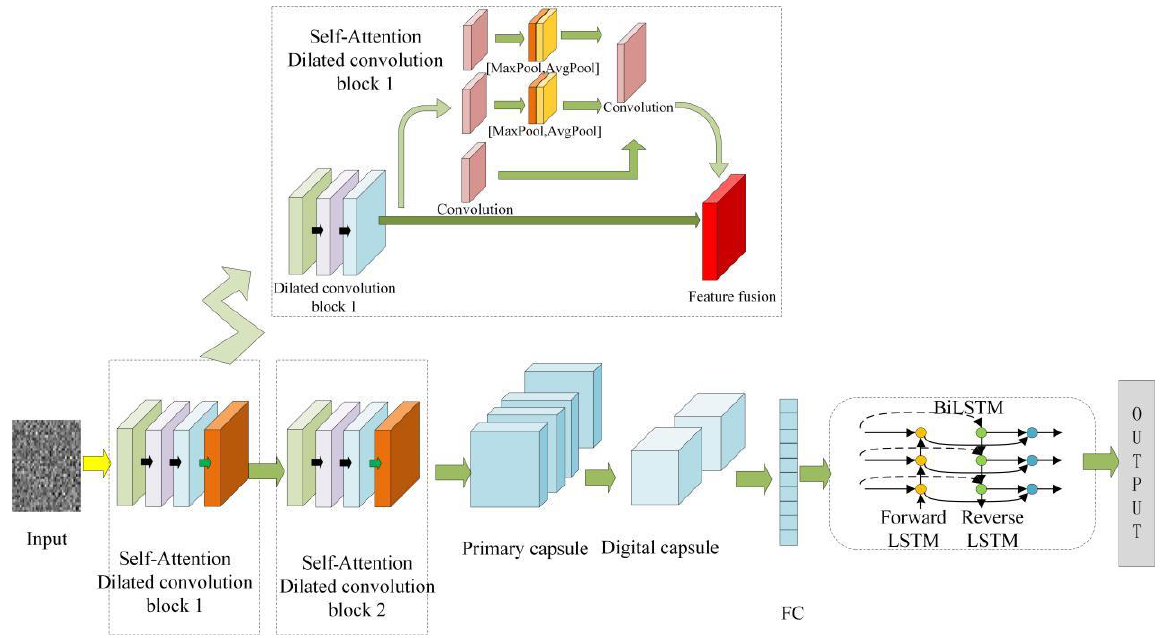
Figure 7. DACapsNet – BiLSTM model. Figure 7. DACapsNet–BiLSTM